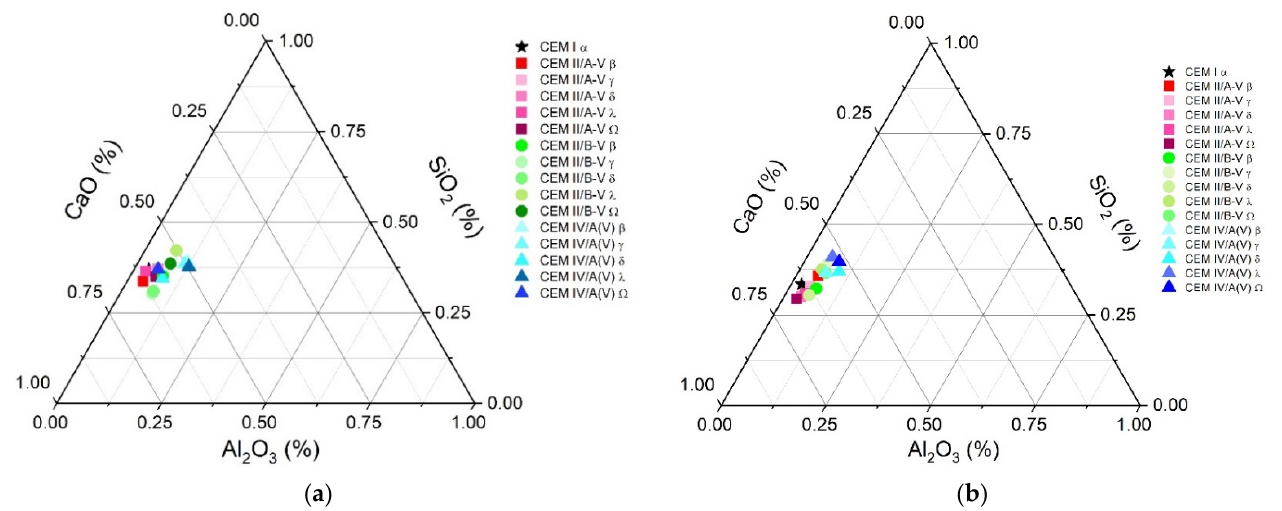
Figure 16. Energy-dispersive X-ray spectroscopy (EDX) paste composition: ( a ) 28 days; ( b ) 90 days.